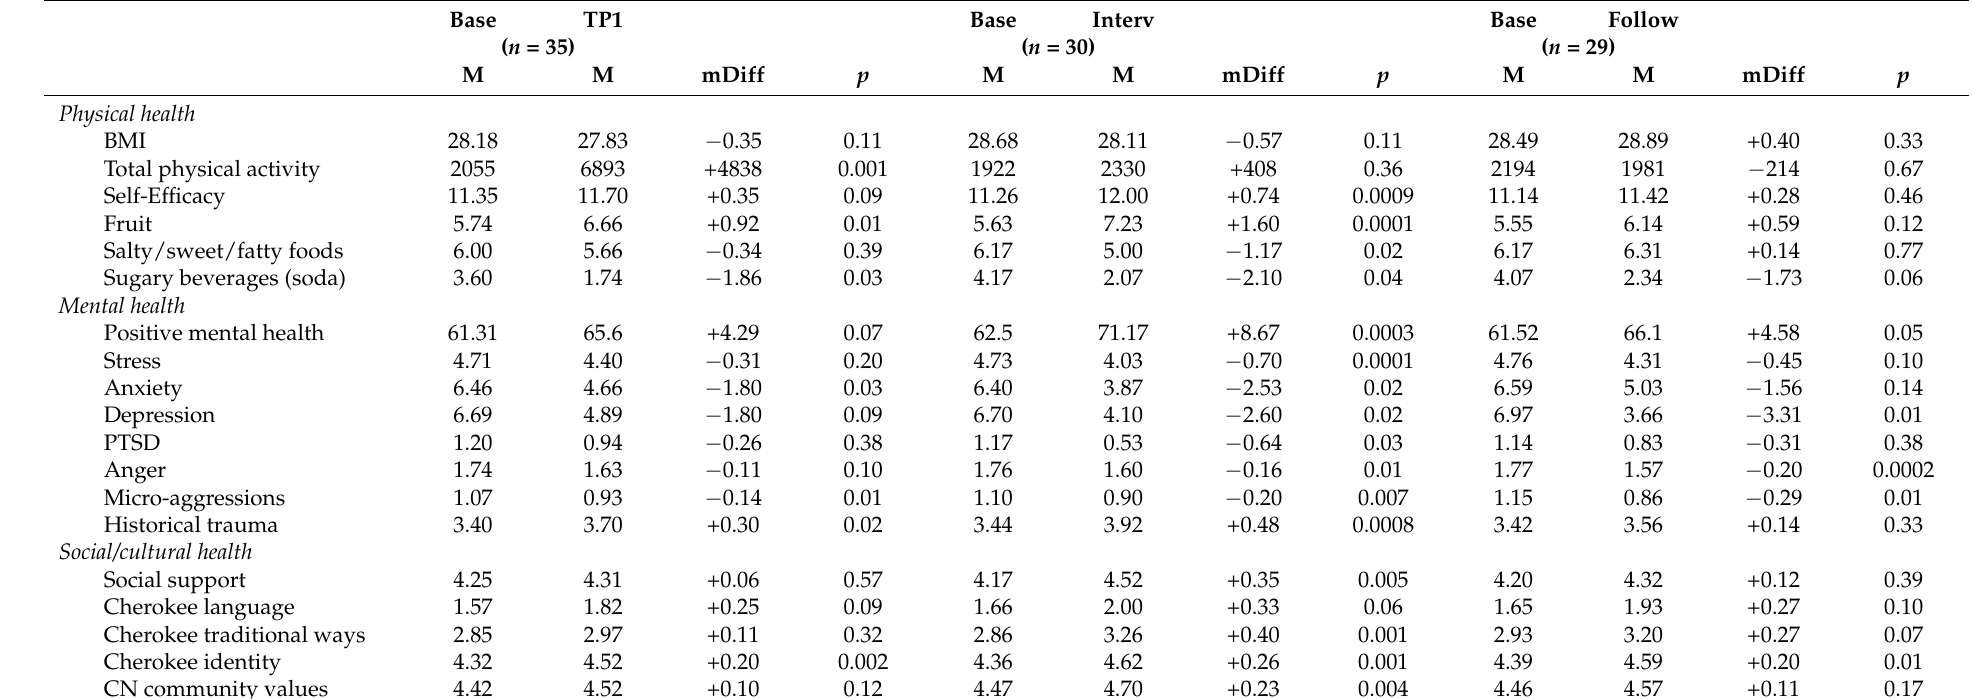
Table 3. Summary statistics of select